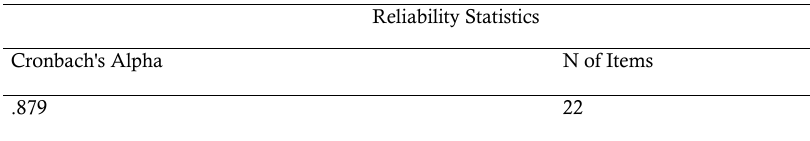
Table 5. Reliability Reliability